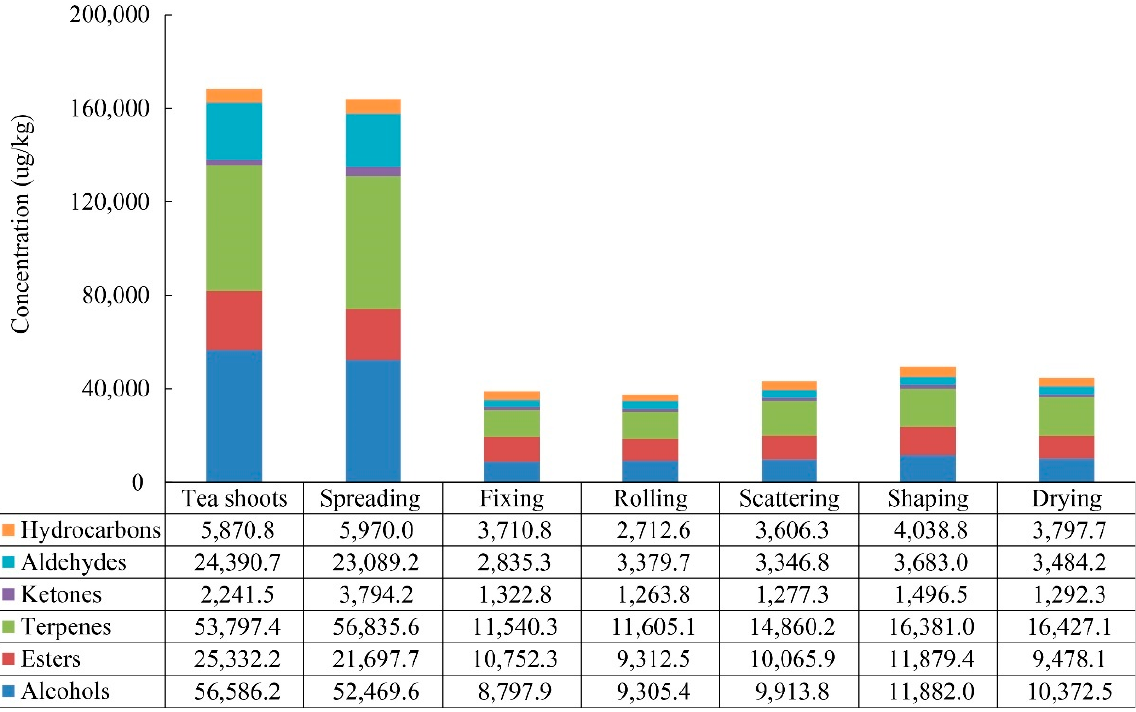
Figure 2. Category and concentrations of volatile compounds in XYMJ green tea during manufac- turing.